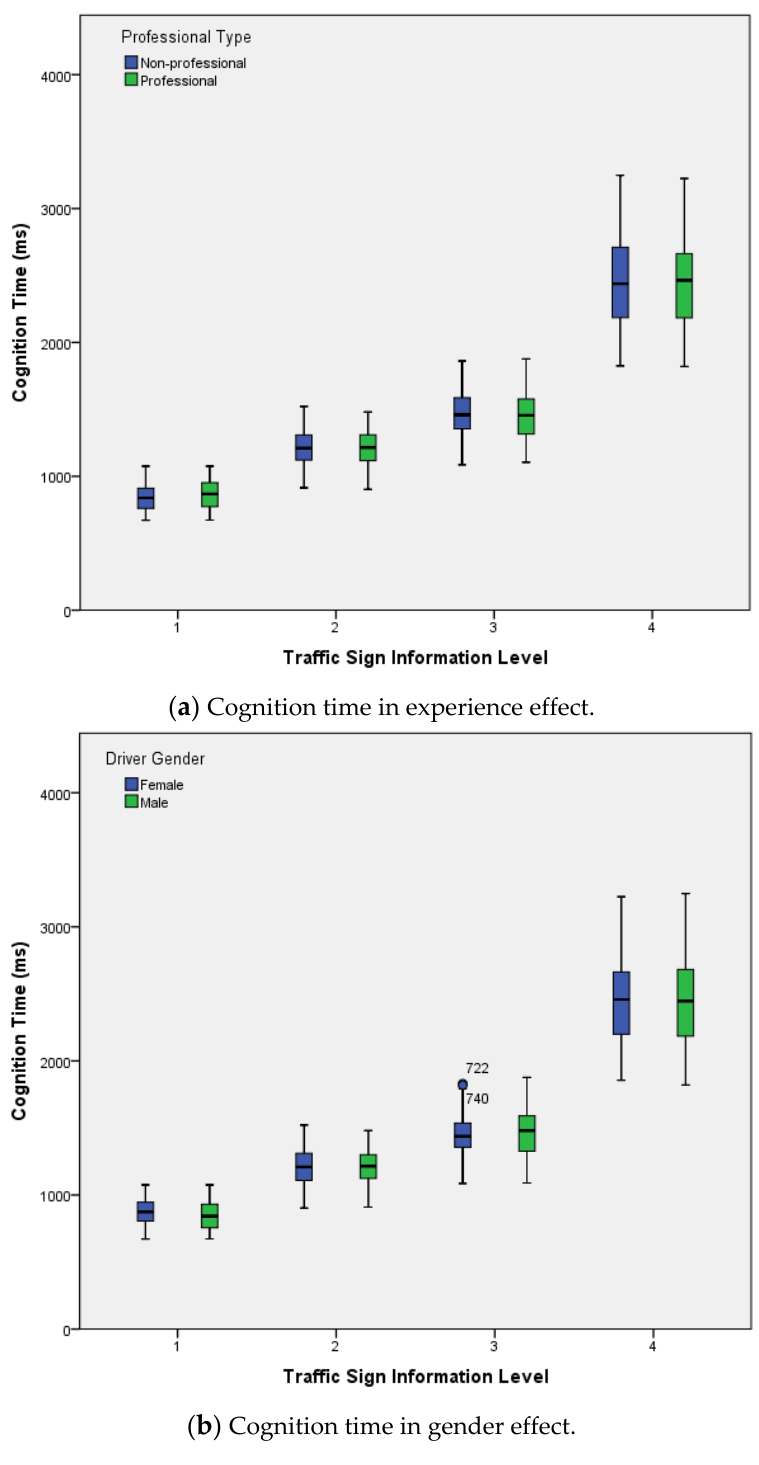
Figure 4. The reaction time of subjects to signs in different levels of information.